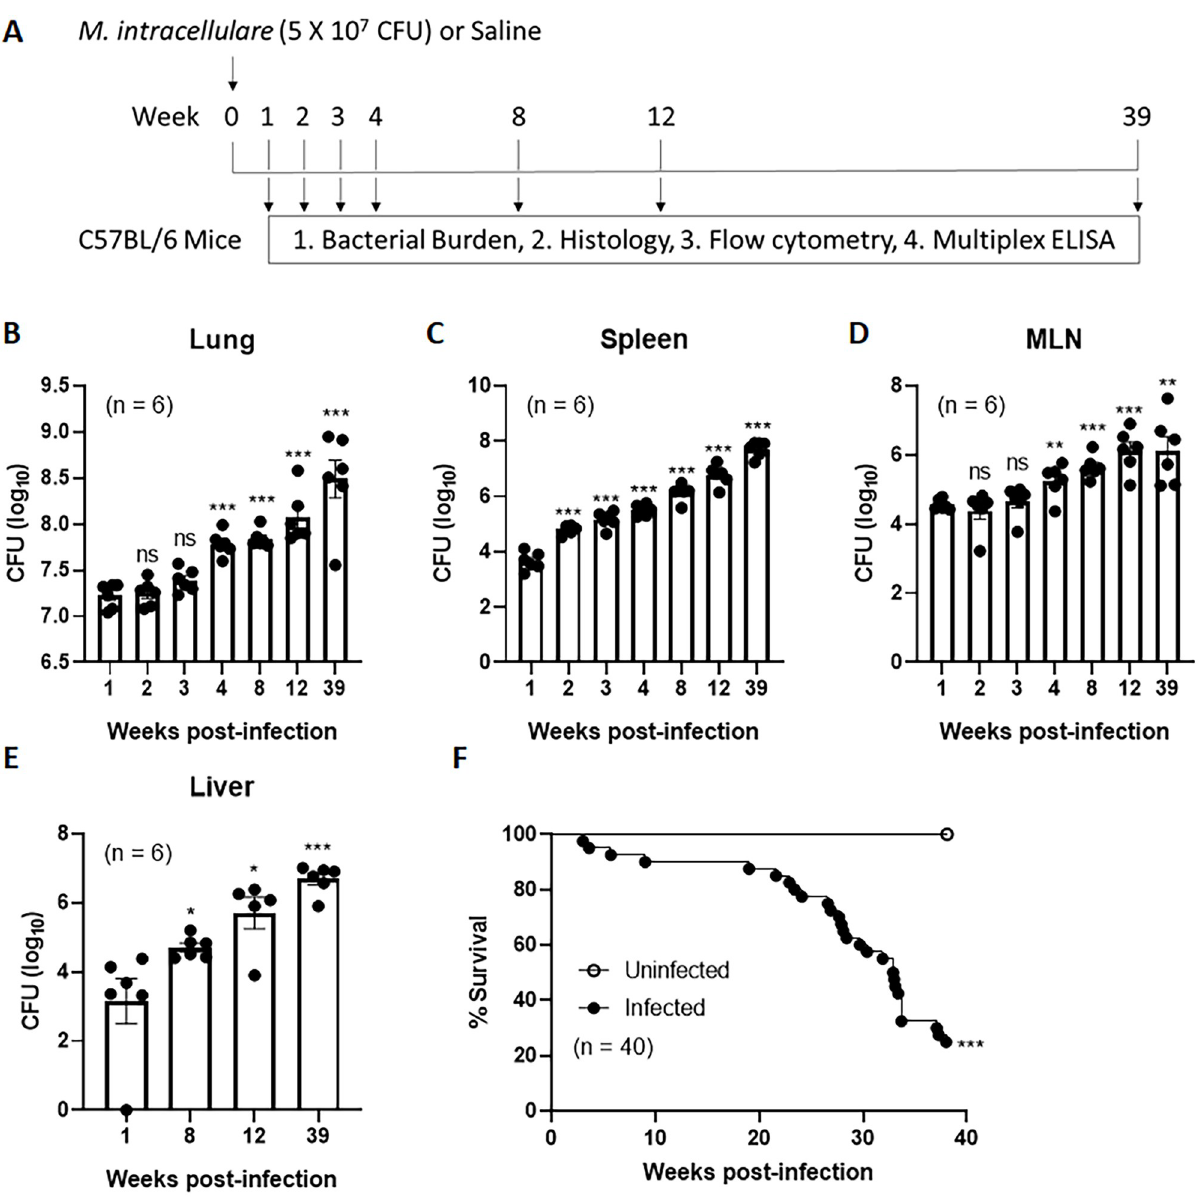
Fig 1. M . intracellulare infection causes persistent bacterial growth and mortality in mice. ( A ) Schematic representation of M . intracellulare infection and experimental schedule. C57BL/6 mice were infected with clinical isolates of M . intracellulare (5 × 10 7 CFU) via the intranasal route. The bacterial burden in the lungs after 24 h was 3.3 × 10 7 CFU. Mice were sacrificed at 1, 2, 3, 4, 8, 12 and 39 weeks postinfection. Bacterial burden, histological analyses, immune cell subpopulation (by flow cytometry) and cytokine/chemokine levels (by multiplex ELISA) were evaluated at each indicated time. ( B-E ) Bacterial burden was determined in the lungs (B), spleen (C), mediastinal lymph nodes (MLN) (D), and liver (E). Data were pooled from two independent experiments (total n = 6 mice per indicated time point). Data are expressed as the means ± SEM. � P < 0.05, �� P < 0.01, and ��� P < 0.001 compared with 1 week postinfection. ( F ) A mortality study was performed separately. Twenty mice per group were used in this study and experiments were repeated two times. Survival curves for uninfected control (white circles) and M . intracellulare -infected mice (black circles). Data were pooled from two independent experiments (total n = 40 mice per group). Survival curves were compared using the log rank test. ��� P < 0.001.